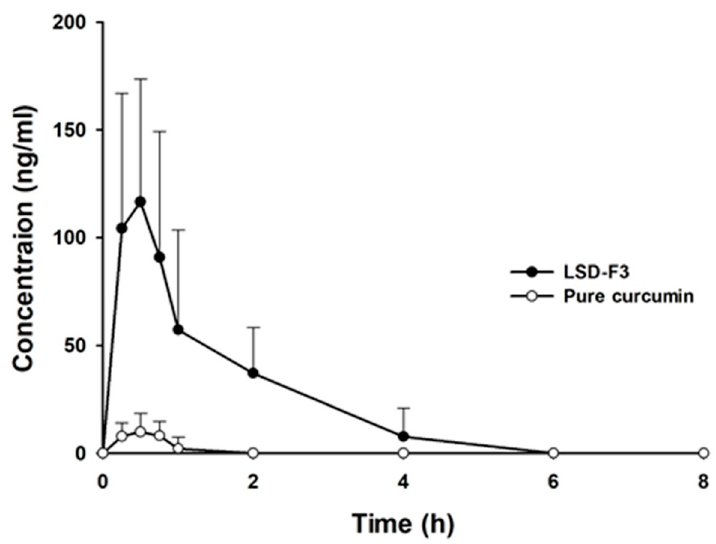
Figure 7. Pharmacokinetic profiles of curcumin following an oral administration of curcumin in different formulations to rats (Mean ± SD, n = 6). The dose was equivalent to 100 mg/kg of curcumin.